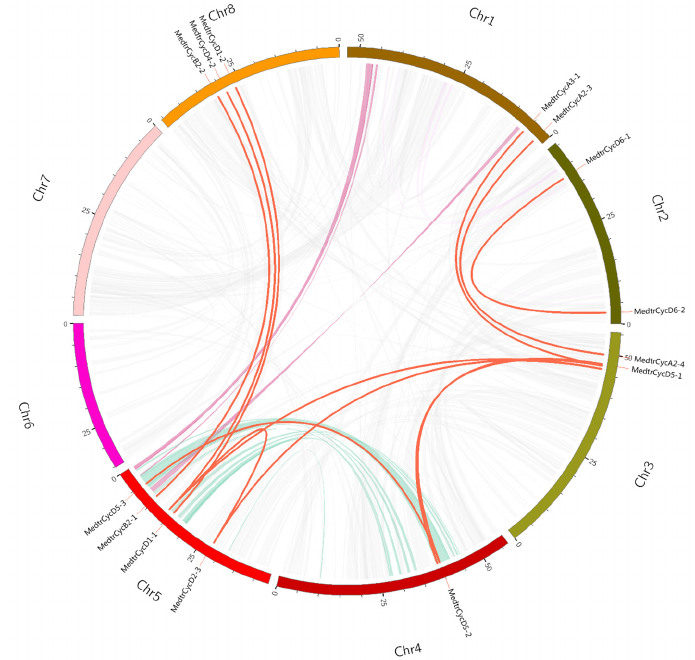
Figure 2. Circos figure for chromosome locations with Mtcyclin segmental duplication links. The red lines indicate segmented duplicated gene pairs.